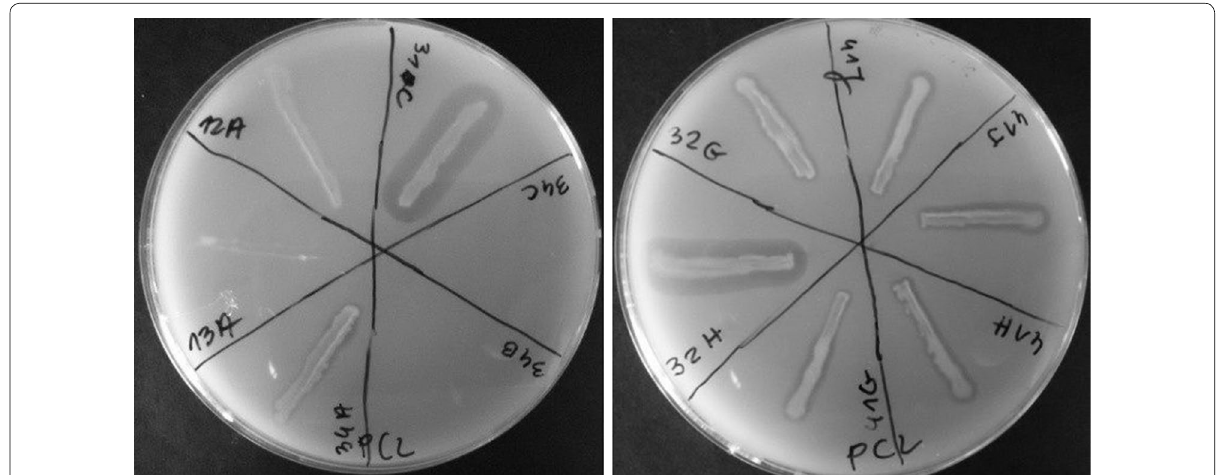
Fig. 1 Example of an initial test of biodegradability